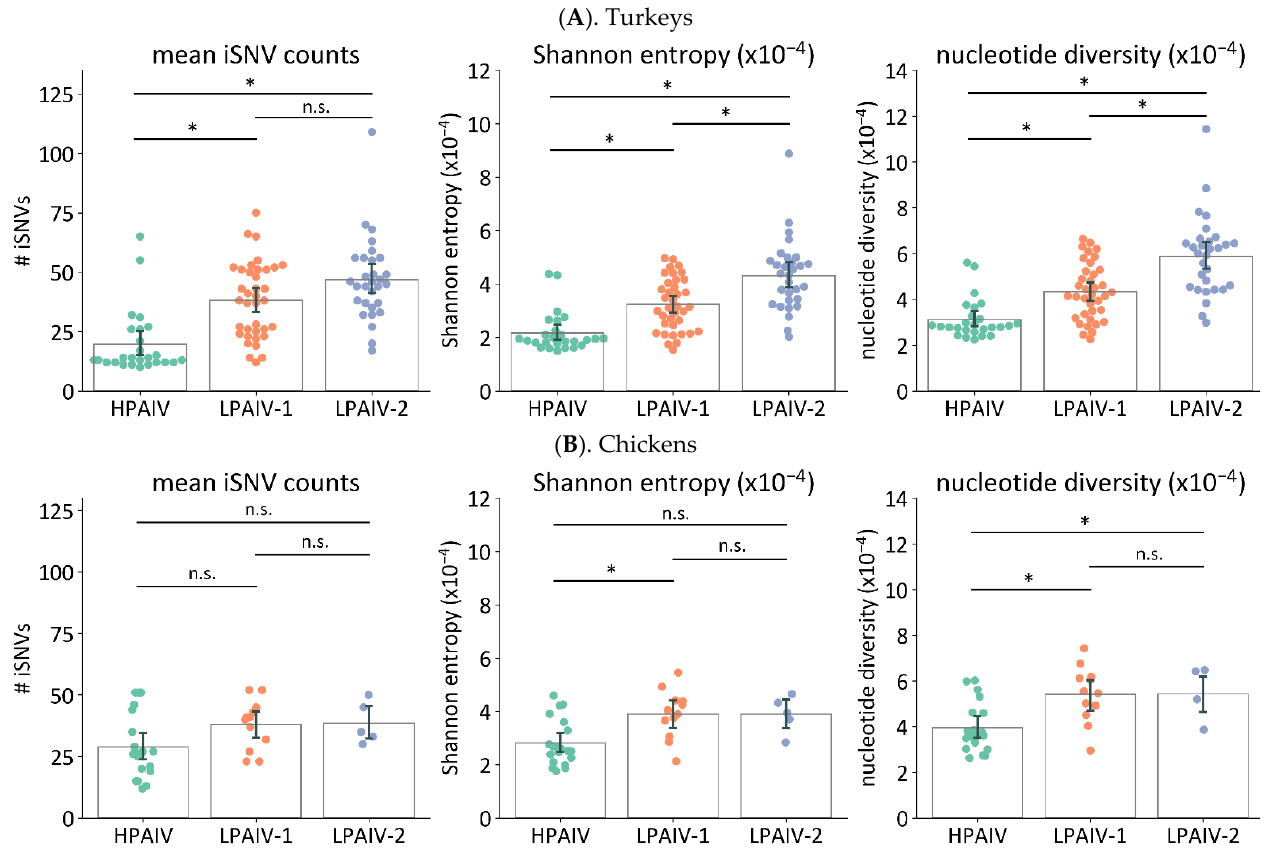
Figure 4. Comparison of iSNV diversity among the three H7N3 viruses in swab samples. Virus genomes from each swab sample from directly inoculated turkeys ( A ) and chickens ( B ) were sequenced and iSNVs identified. The iSNV diversity in each sample was examined by three measurements: mean iSNV count per sample, Shannon entropy, and nucleotide diversity. Asterisks (*) indicate p < 0.05 for indicated groups using Kruskal – Wallis and Dunn ’ s post hoc test for multiple comparisons. n.s. = not significant with p ≥ 0.05.